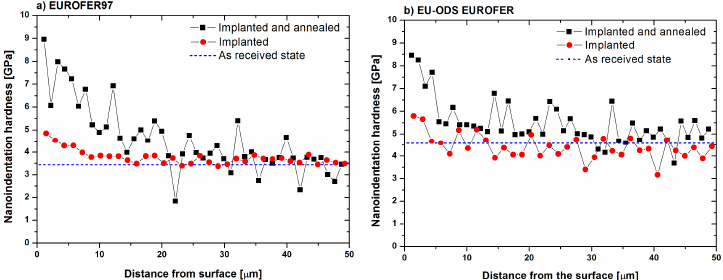
Figure 2. Hardness values vs. distance from the implanted surface of ( a ) EU-ODS EUROFER and ( b ) EUROFER97 irradiated with He from 2 to 15 MeV: Black dotted line represents the values for the annealed state at 450 °C for 100 h. Red dotted are the hardness values for the implanted at RT previous annealing and blue dashed line represents the as received hardness values. All the measurements were performed at 5 mN.